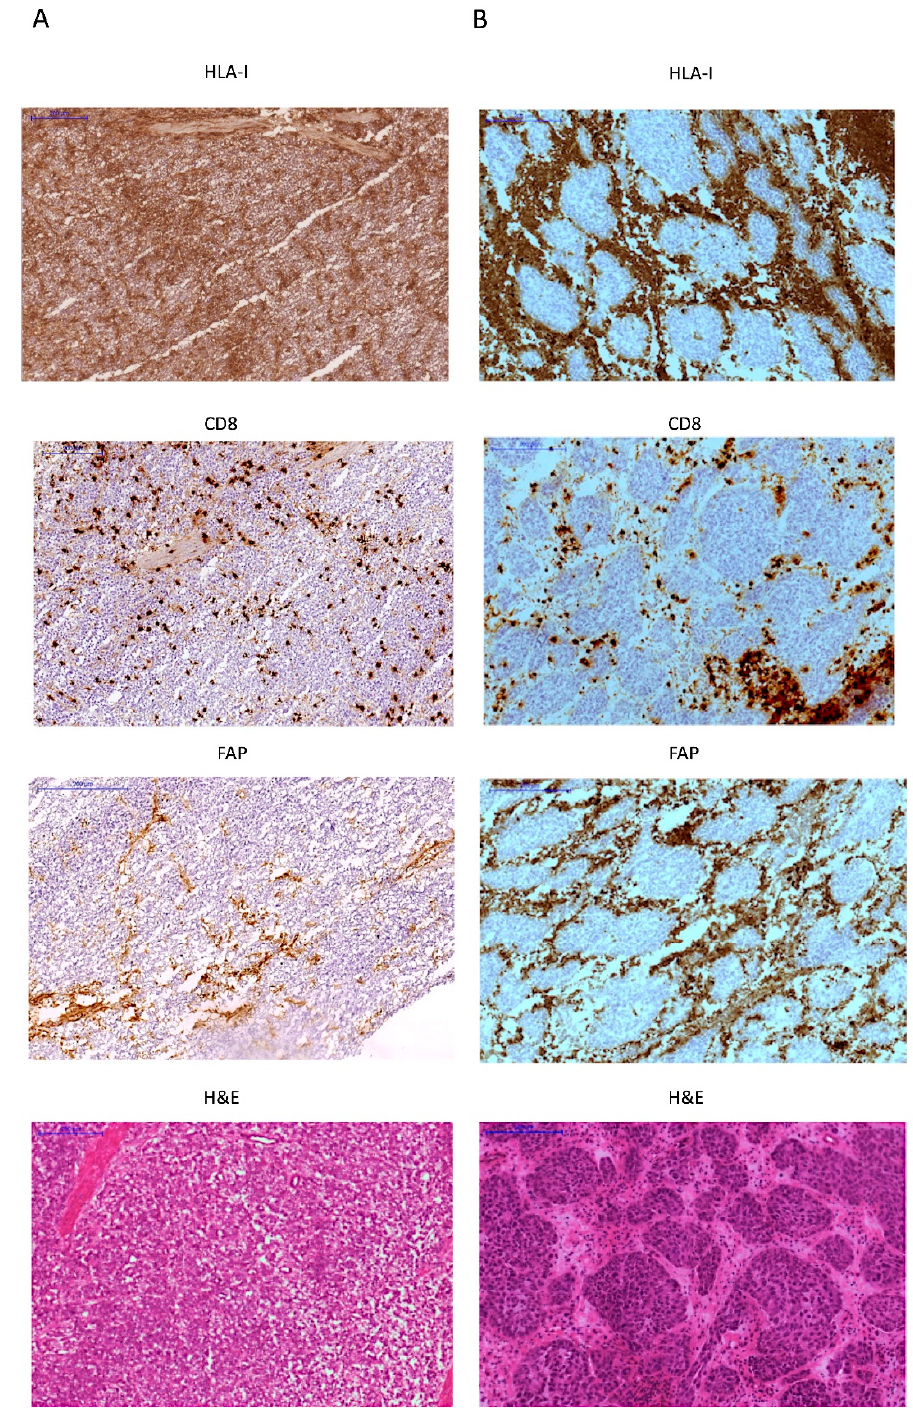
Figure 4. Two different examples of FAP expression in the stroma in high grade tumors. ( A ) HLA- I/PD-L1 double positive tumor heavily infiltrated with T-cells, with few FAP+ stroma cells diffusely distributed in the tumor ( B ) HLA-I negative/PD-L1 positive “encapsulated” tumor with abundant FAP+ cells surrounding HLA-I negative tumor nest and CD8+ T-cells confined in the peritumoral stroma. All images are at 100× magnification.